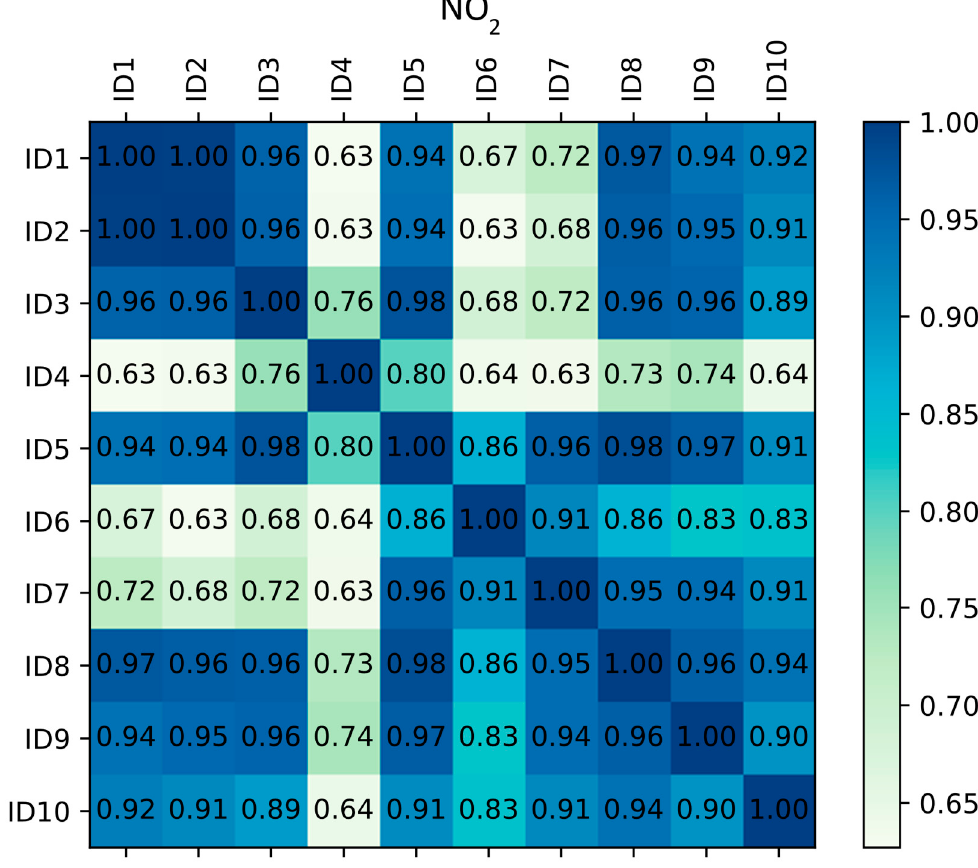
Figure 2. Correlation matrix of co-located low-cost devices for NO 2 .